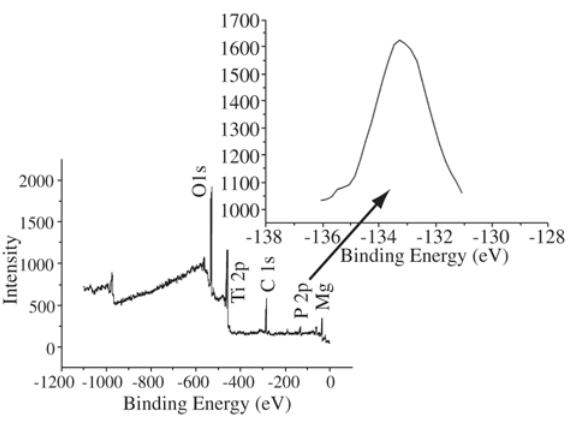
Figure 5. XPS general spectrum of a titanium sheet anodized with PO solution. On detail the P1p region is H 3 4